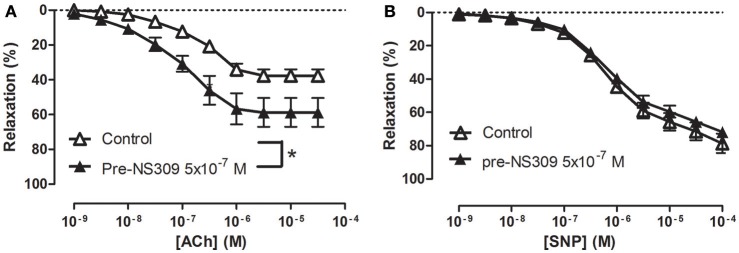
An opener of KCa2.x and KCa3.1 channels, NS309 selectively enhances acetylcholine relaxation in rat corpus cavernosum. Concentration-response curves for (A) acetylcholine (ACh) in the absence (n = 16) and the presence of NS309 (0.5 μM, n = 6), and (B) sodium nitroprusside (SNP) in the absence (n = 5) and in the presence of NS309 (n = 5) in noradrenaline (1 μM)-contracted corpus cavernosum strips. Data are expressed as means ± S.E.M. *P ≤ 0.05, curves were significantly different, two-way ANOVA followed by a Bonferroni's post-test.